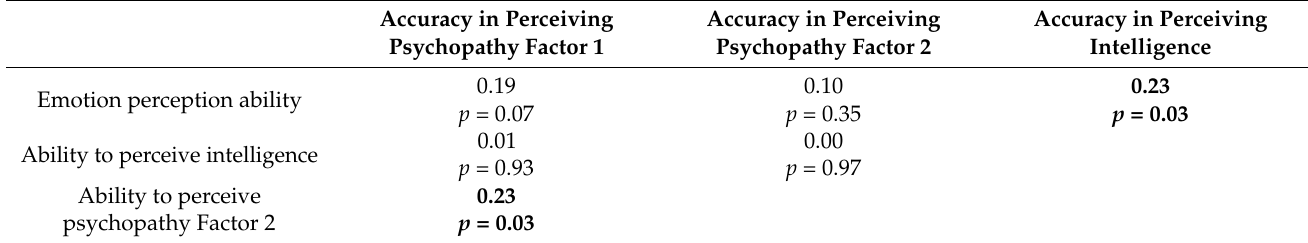
Table 2. Study 1: Manifest correlations of trait perception abilities with emotion perception